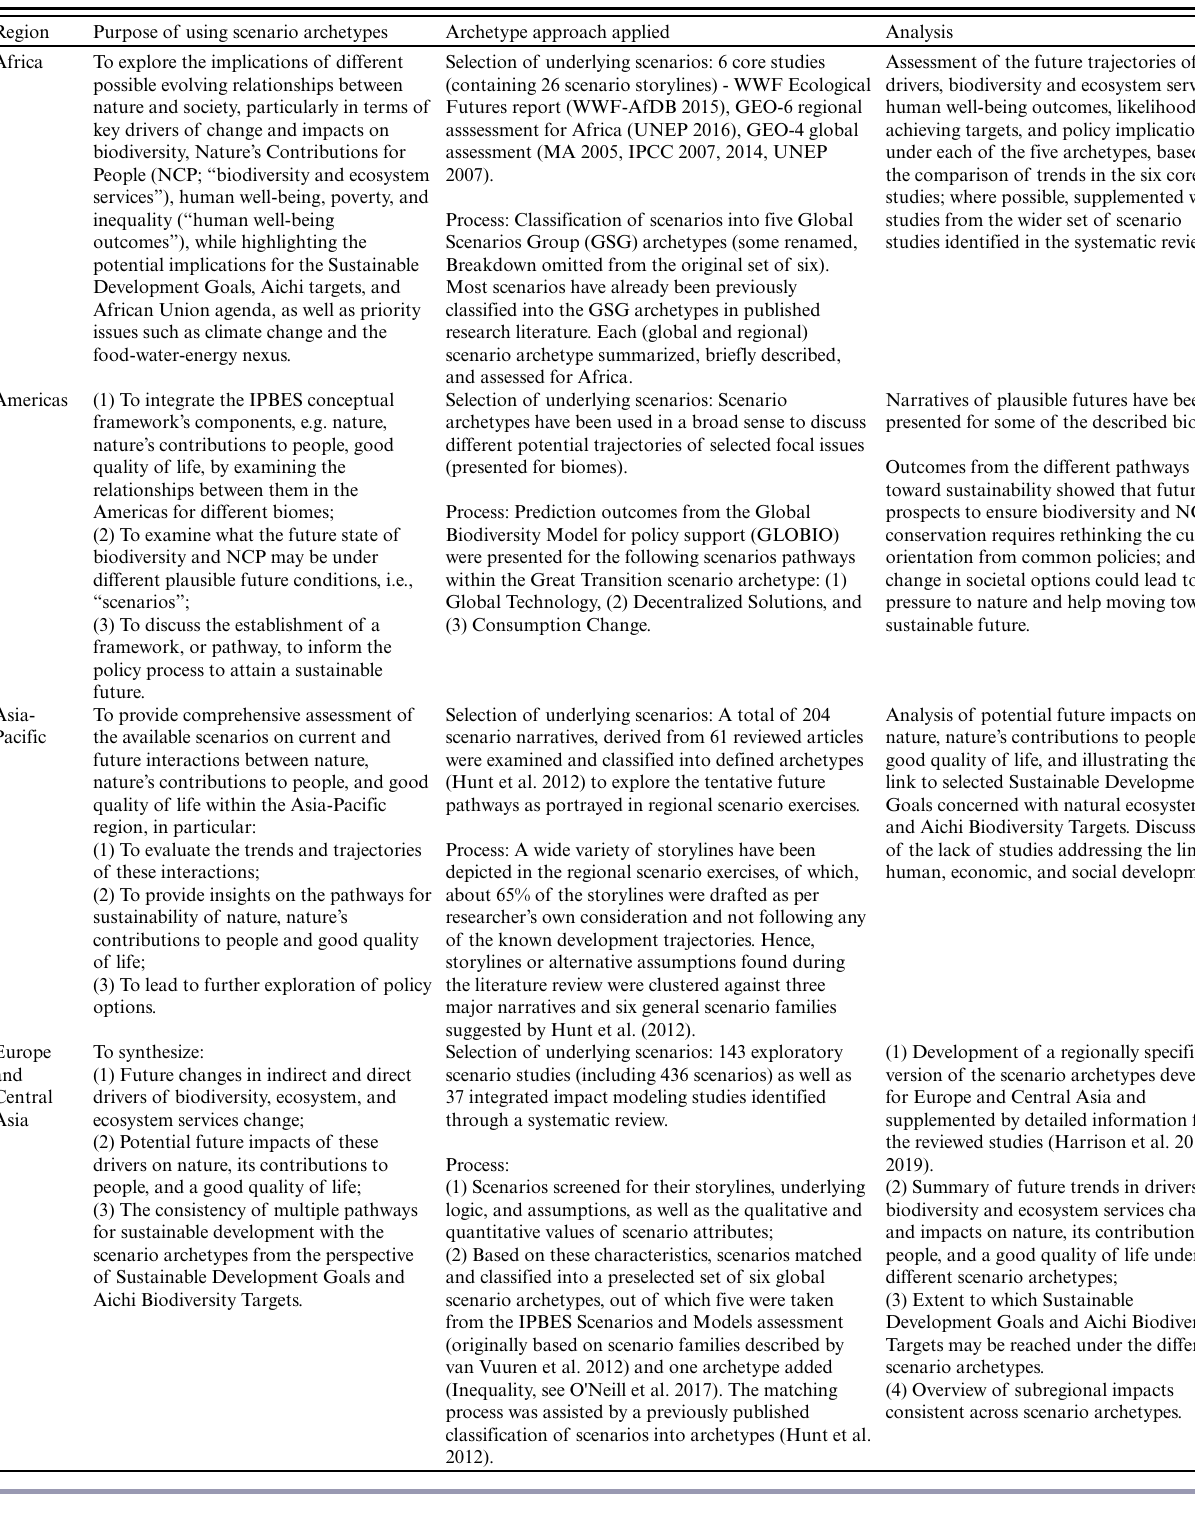
Table 2 . Table outlining the different purposes, archetype approach, and subsequent analyses taken by each of the Intergovernmental Science-Policy Platform for Biodiversity and Ecosystem Services (IPBES) regional assessments (Africa, Americas, Asia Pacific, and Europe and Central Asia), outlined in more detail in the full reports (Biggs et al. 2018, Gundimeda et al. 2018, Harrison et al. 2018, Klatt et al. 2018; available online at: